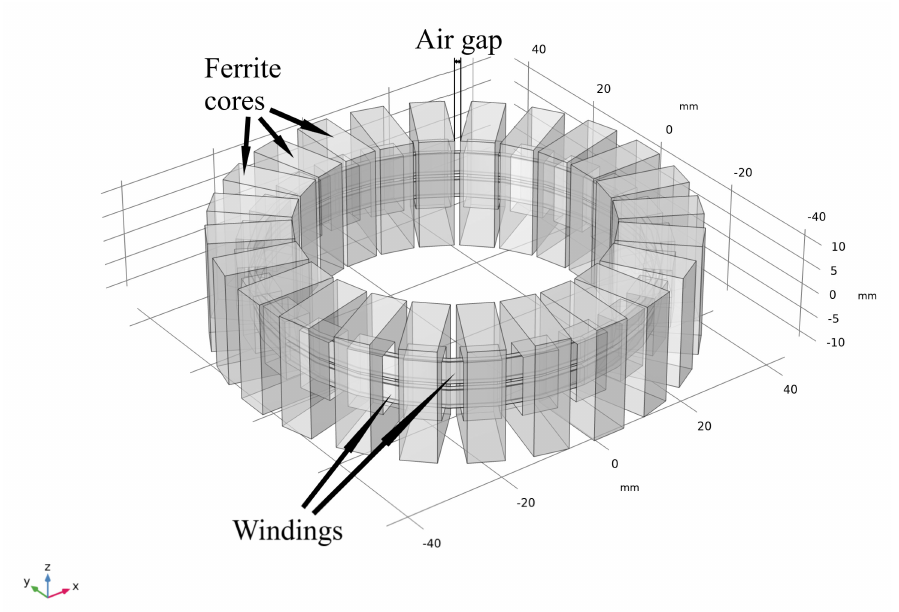
Figure 13. COMSOL simulation model of the prototype HF transformer.